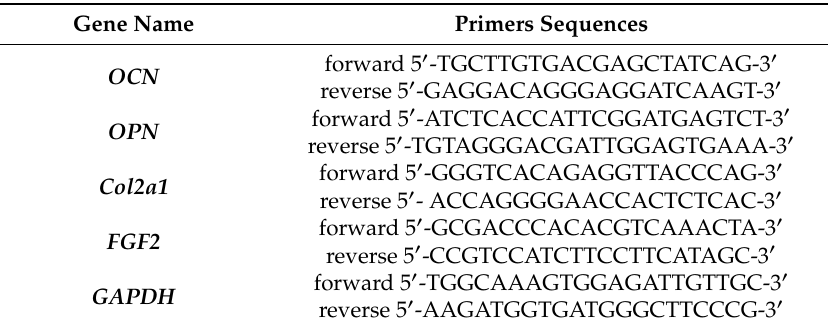
Table 1. siRNA knockdown of T β RII